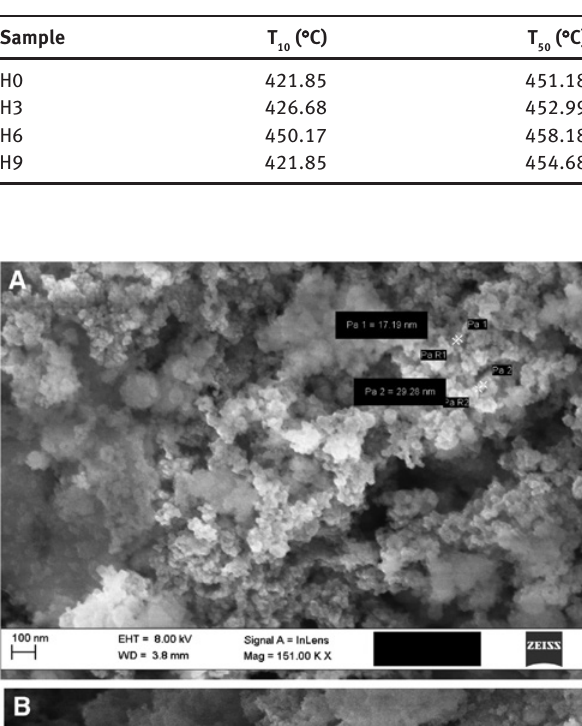
Table 2: TGA data of neat PP and the PP/Ni-LDH, PP/m.Ni-LDH, and PP/Cu-LDH composites.